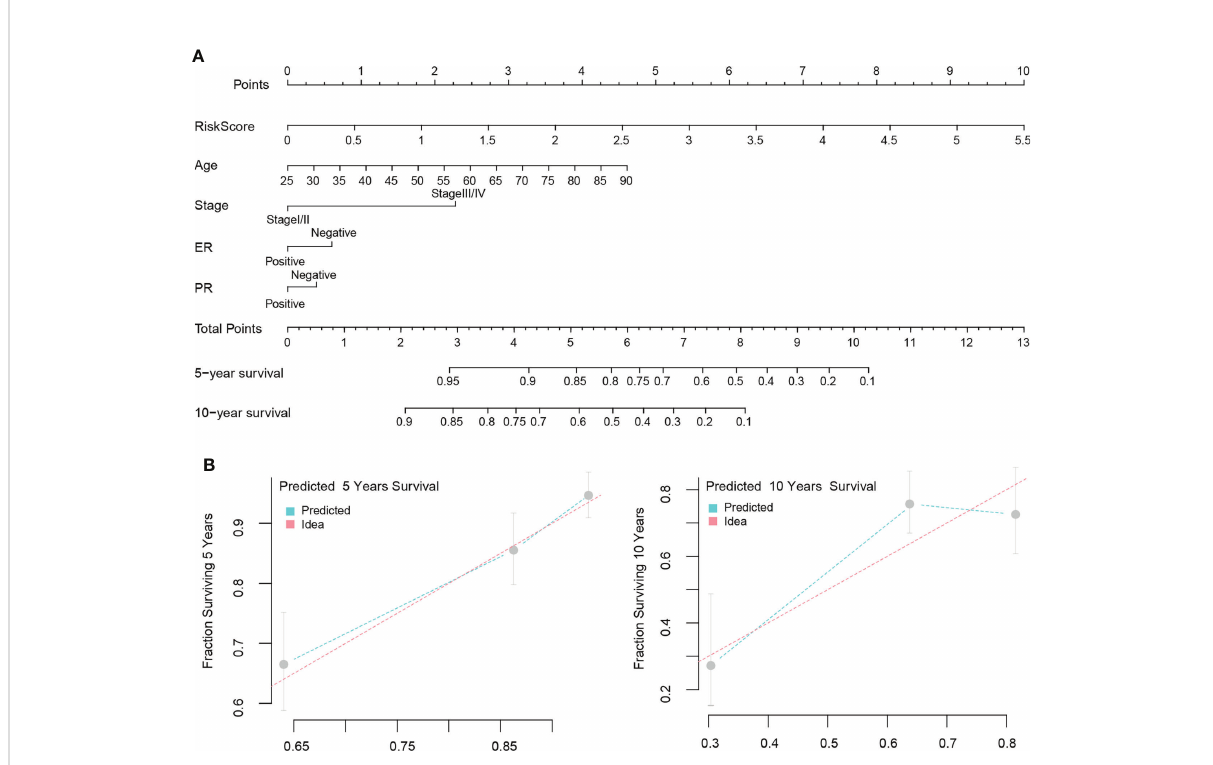
FIGURE 8 Nomogram modeling and ef fi cacy evaluation. Combine multivariate analysis results with clinical value to construct a nomogram model to predict the OS of patients (A) . The 5 and 10 years prediction curve of model had a small bias from the ideal curve (B)